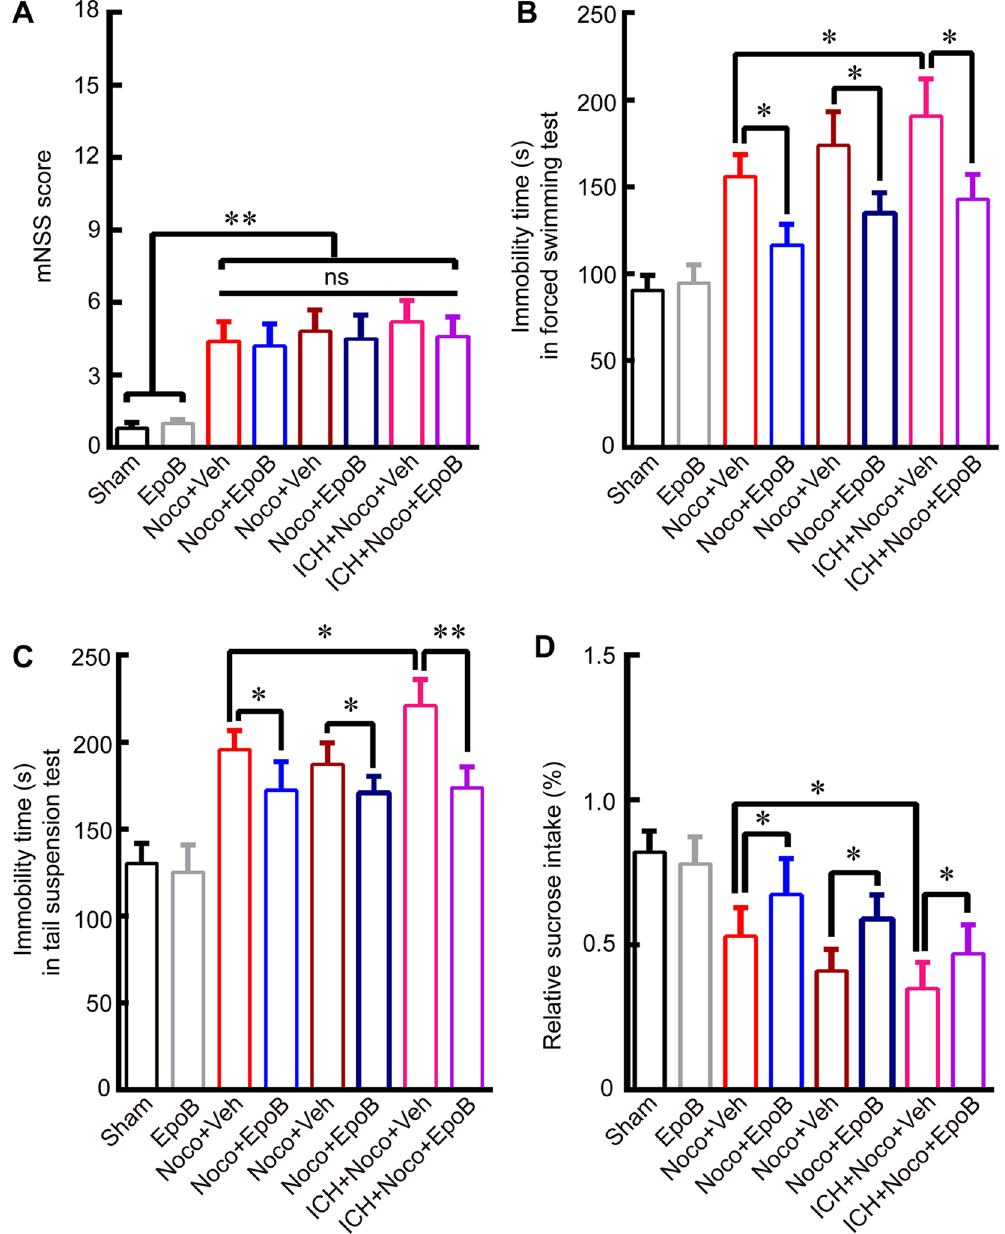
Figure 5. EpoB treatment alleviates depression-like behavior after ICH and Noco injection. ( A ) mNSS score at 14 days after ICH or Noco injection for all treatment groups. ( B - C ) Quantitative data for immobility time (s) in the FST (A) and TST (B) in mice in the eight groups at 14 days after ICH and Noco injection. ( D ) Quantitative data for relative sucrose intake (%) in the eight groups at 14 days post-ICH and Noco injection. Data are shown as the means ± SEM (at least n = 8 for the behavior tests in each group; * P < 0.05, ** P < 0.01 and ns = not